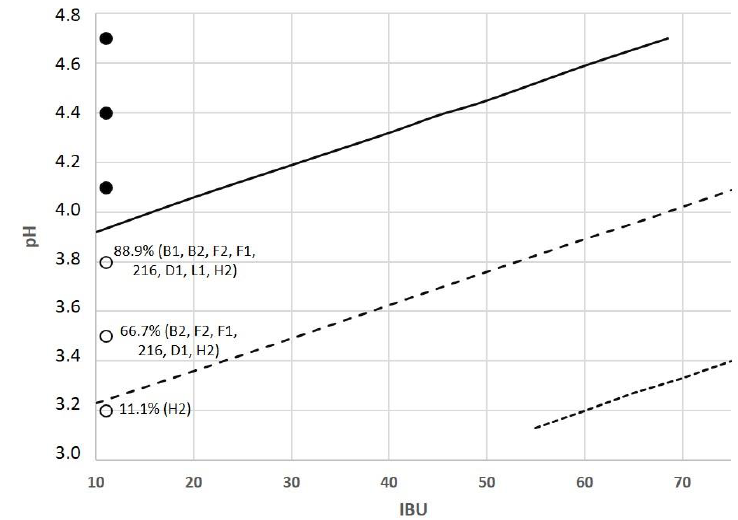
Figure 5. Contour plots for the observed growth responses and predicted probabilities (P = 0.1 ( ⋯⋯ ), P = 0.5 (- - -), and P = 0.9 (—)) for the microbial spoilage of craft beer as a function of IBU and pH. Values of % ABV and % YFE were set at 0.5 and 1.45, respectively. (●) P = 1 (growth), ( ○ ) P = 0 (no growth). Percentages indicate the proportion of strains showing growth, being described between brackets.